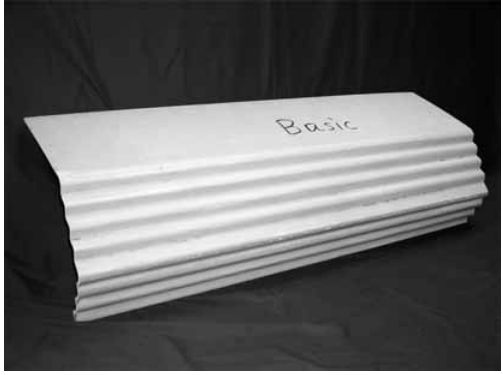
Fig. 12. Basic shield.